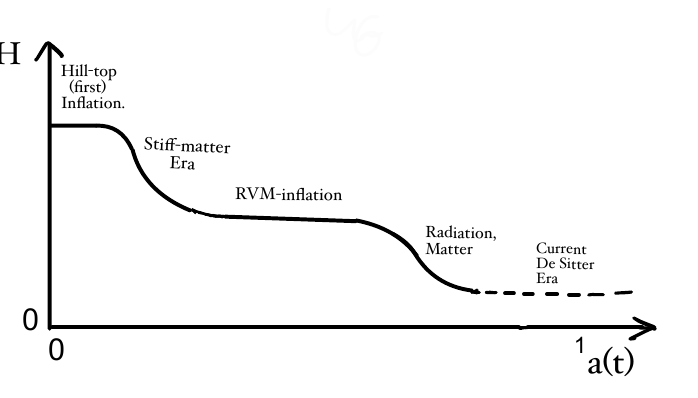
Figure 2. Diagram of the Hublle parameter ( H ) vs. the scale factor a ( t ) in the stringy RVM in the scenario with two inflationary epochs, separated by a stiff-KR-axion dominated era. The first (hill-top) inflation, near the Big Bang ( a ( t ) → 0), occurs in models with dynamical supergravity breaking, as a result of gravitino condensation [133]. The second inflation is of RVM type and is due to GW-induced condensation of gravitational anomalies, which characterise the string-inspired gravitational model at early epochs. In string theory models, due to higher-curvature corrections in the low-energy target-space effective action, an initial singularity of the universe might be avoided. This is a featured shared with the RVM cosmology. Figure taken from